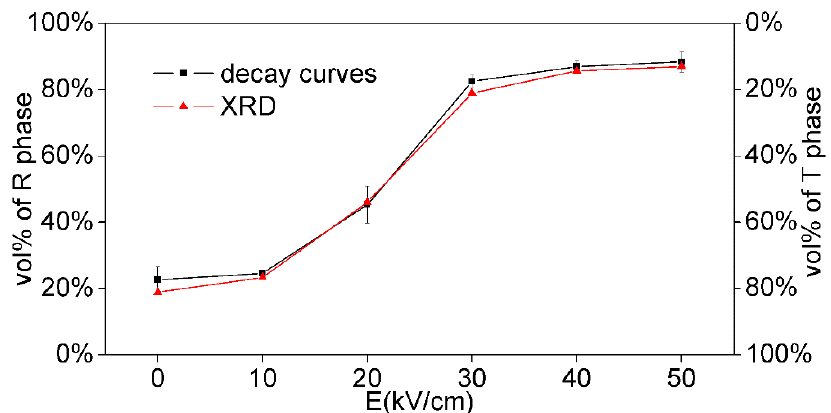
Figure 5. Variations of the phase fractions of NKBET20 ceramics poled under various electric fields from decay curves and XRD analyses.